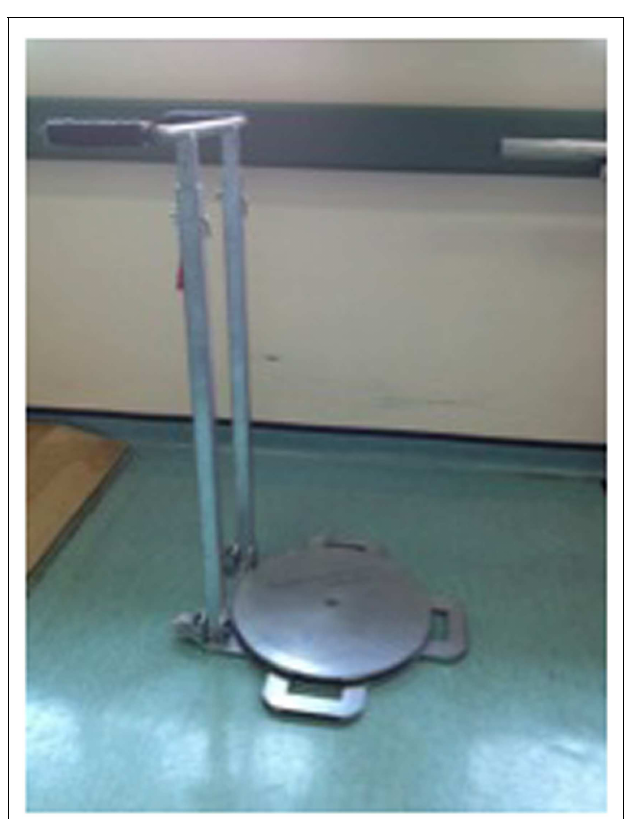
FIGURE 1 |The self-standing turning transfer device .The frame is made of mild steel.The base is stabilized by the weight of the device and its two small feet.The rotating disk turns easily on the base.The handle is height